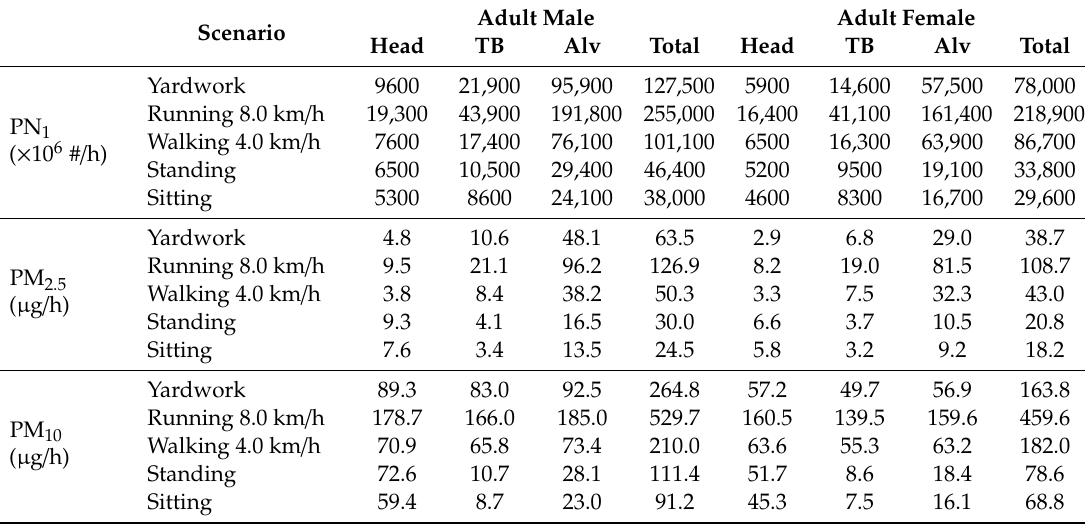
Table 6. Mean regional dose rates (head, tracheobronchial (TB), alveolar (Alv), and total) for aerosol exposure during TYPE II indoor activities. Note that yardwork is assumed to be equivalent to housework and running is equivalent to indoor